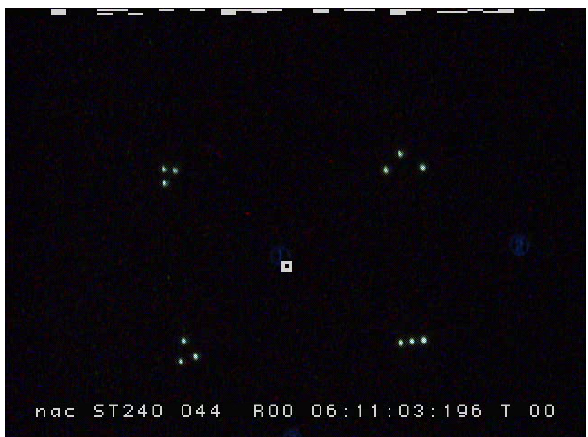
Figure 11: Captured image of the view camera while the subject watching the number 1 on the screen.